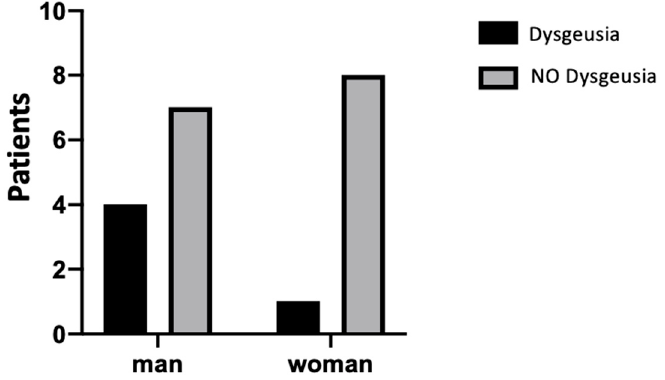
Figure A11. Di ff erence of dysgeusia perception between males and females. No statistical significance Figure A11. Difference of dysgeusia perception between males and females. No statistical significance ( p = 0.31) was shown between the ( p = 0.31) was shown between the sexes. Figure A11. Difference of dysgeusia perception between males and females. No statistical significance ( p = 0.31) was shown between the sexes. Figure A11. Difference of dysgeusia perception between males and females. No statistical significance ( p = 0.31) was shown between the sexes.